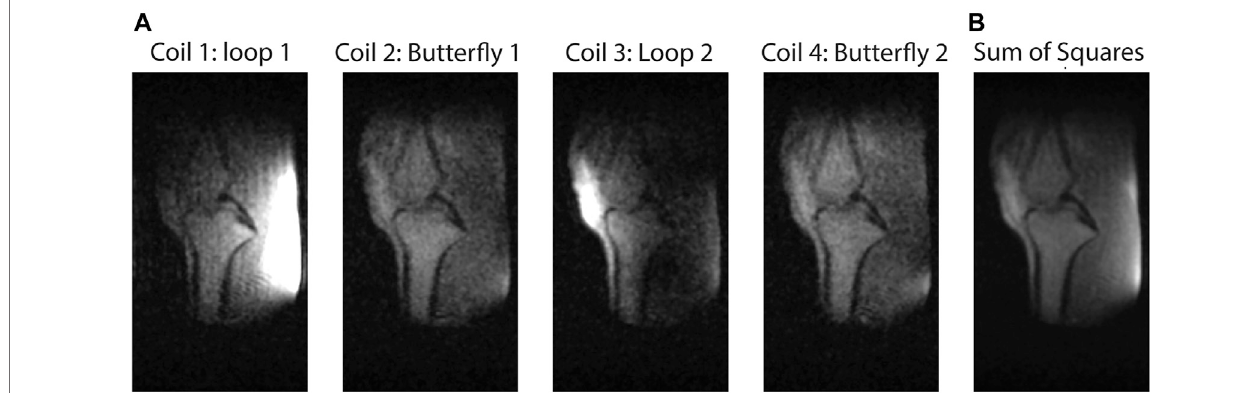
FIGURE 6 | Sagittal slice TSE images of the knee. (A) individual elements. (B) sum of squares. parameters: 150 ( z : right-left) × 165 ( y : posterior-anterior) × 150 ( x : head-feet) mm 3 , data matrix: 200 × 110 × 50, TR/TE: 300/15 ms, echo train length: 4, scan duration 6 min 53 s.